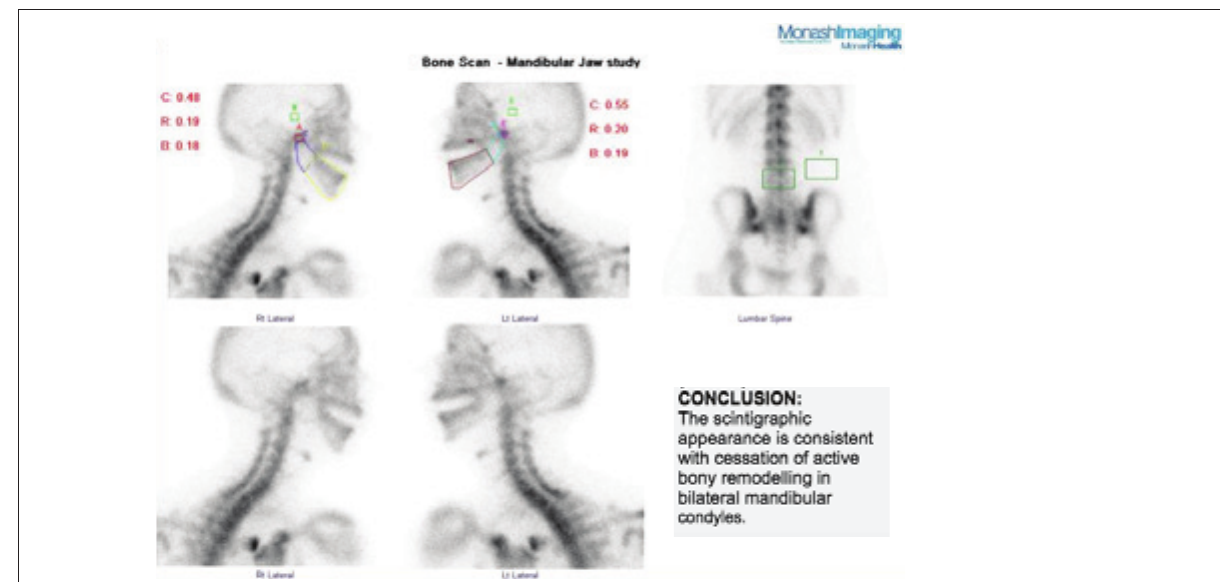
Figure 8. Nuclear medicine bone scan showing cessation of bony remodelling; July